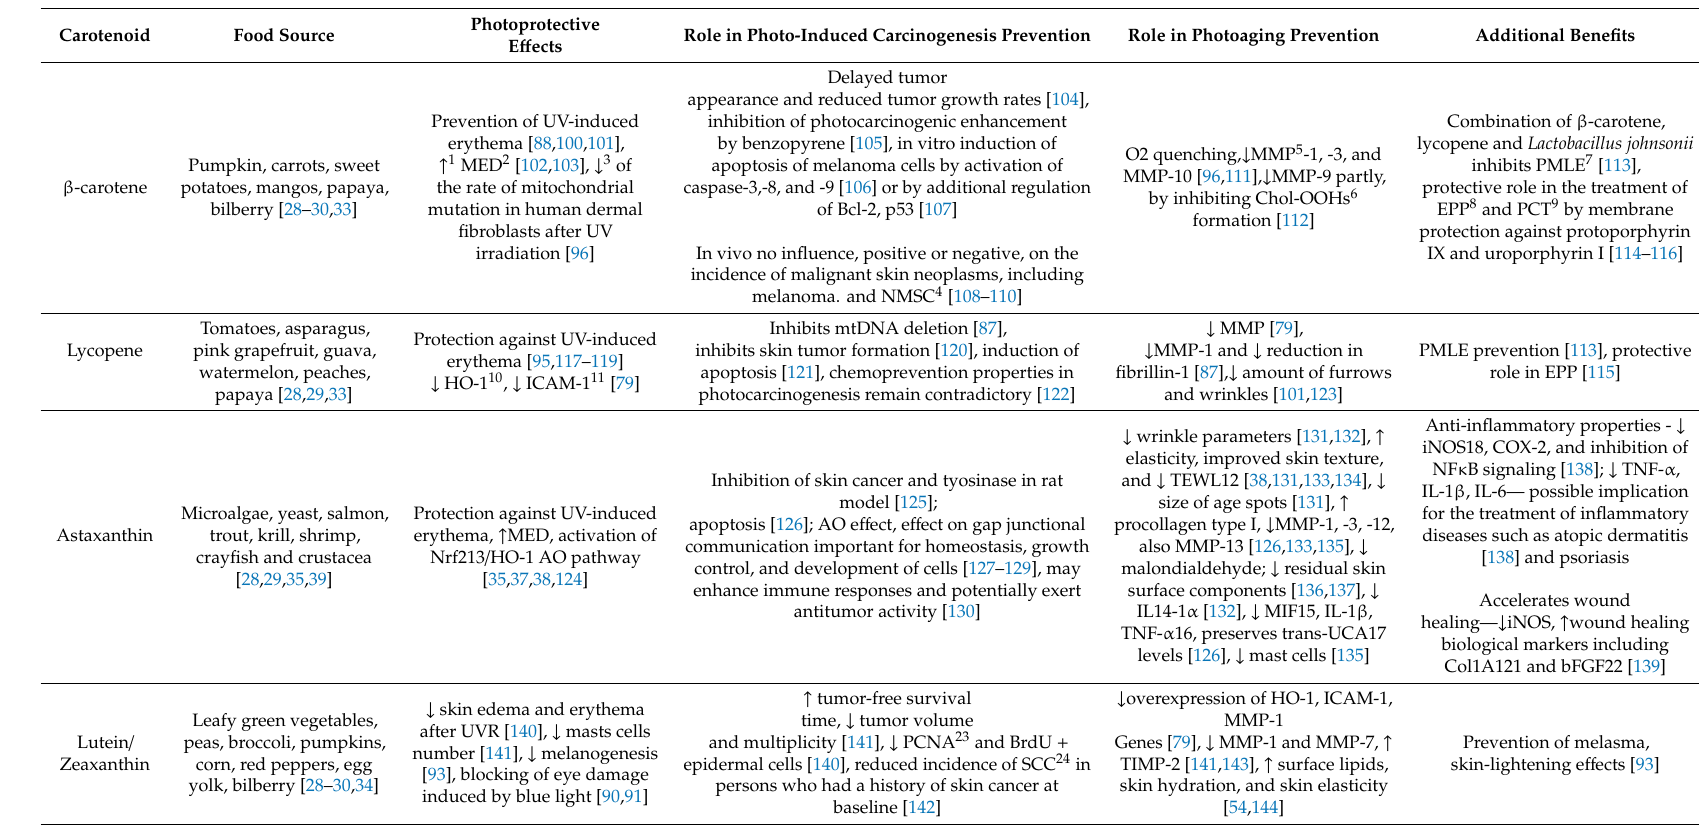
Table 1. Carotenoids in skin health, repair, and